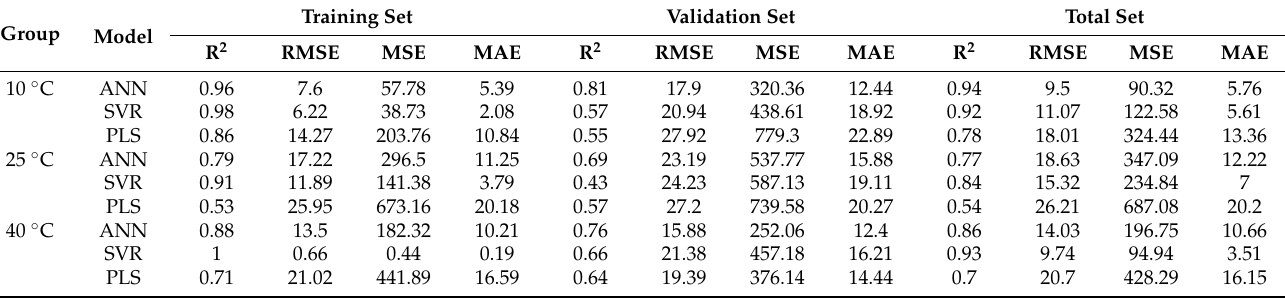
Table 3. The metrics of ANN, SVR, and PLS